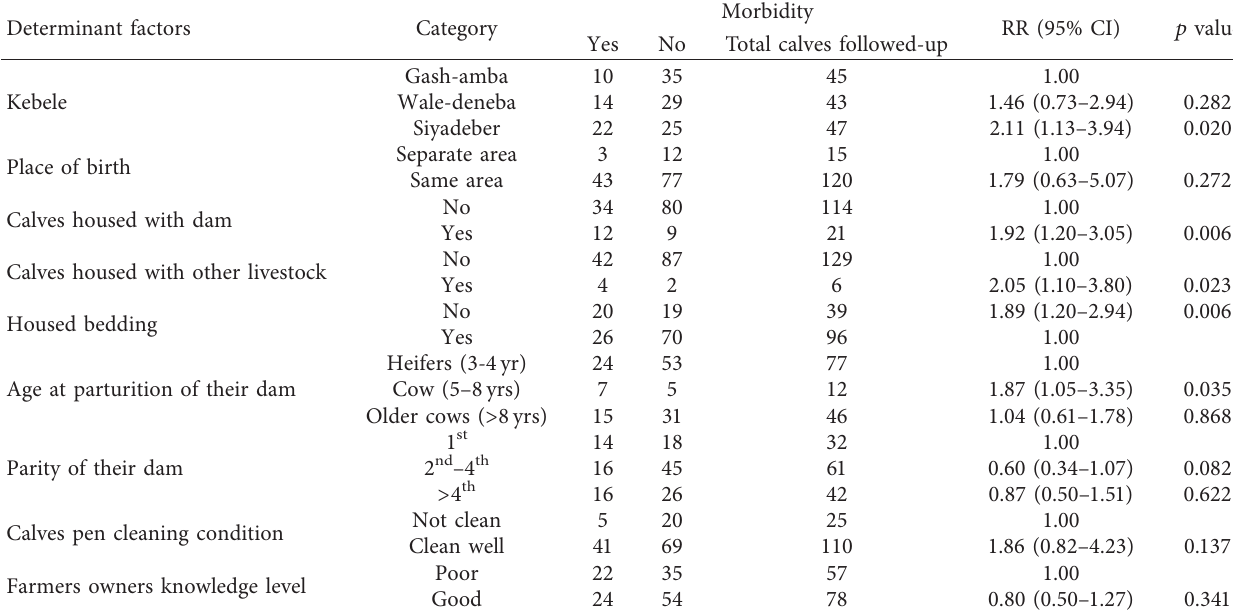
Table 7: Bivariate analysis result for the potential risk factors associated with calves at Siyadeber and Wayu District, North Shewa, Amhara region, Ethiopia.